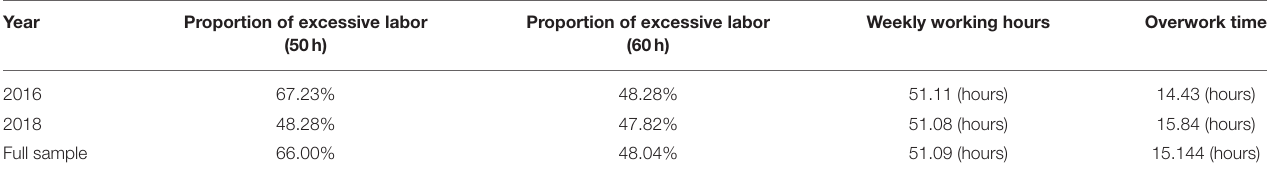
TABLE 1 | Descriptive statistics of changes in migrant workers’